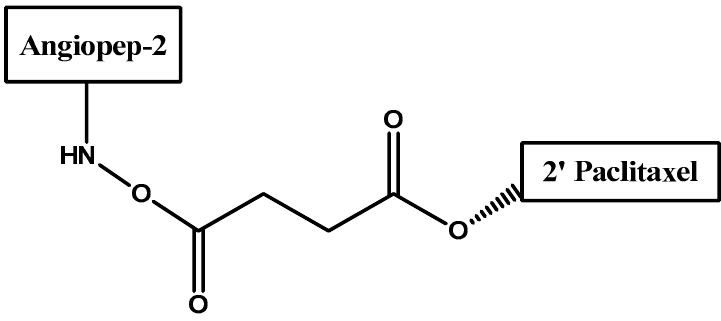
Figure 3. A schematic representation of ANG-1005, a conjugate between paclitaxel and Angiopep-2.